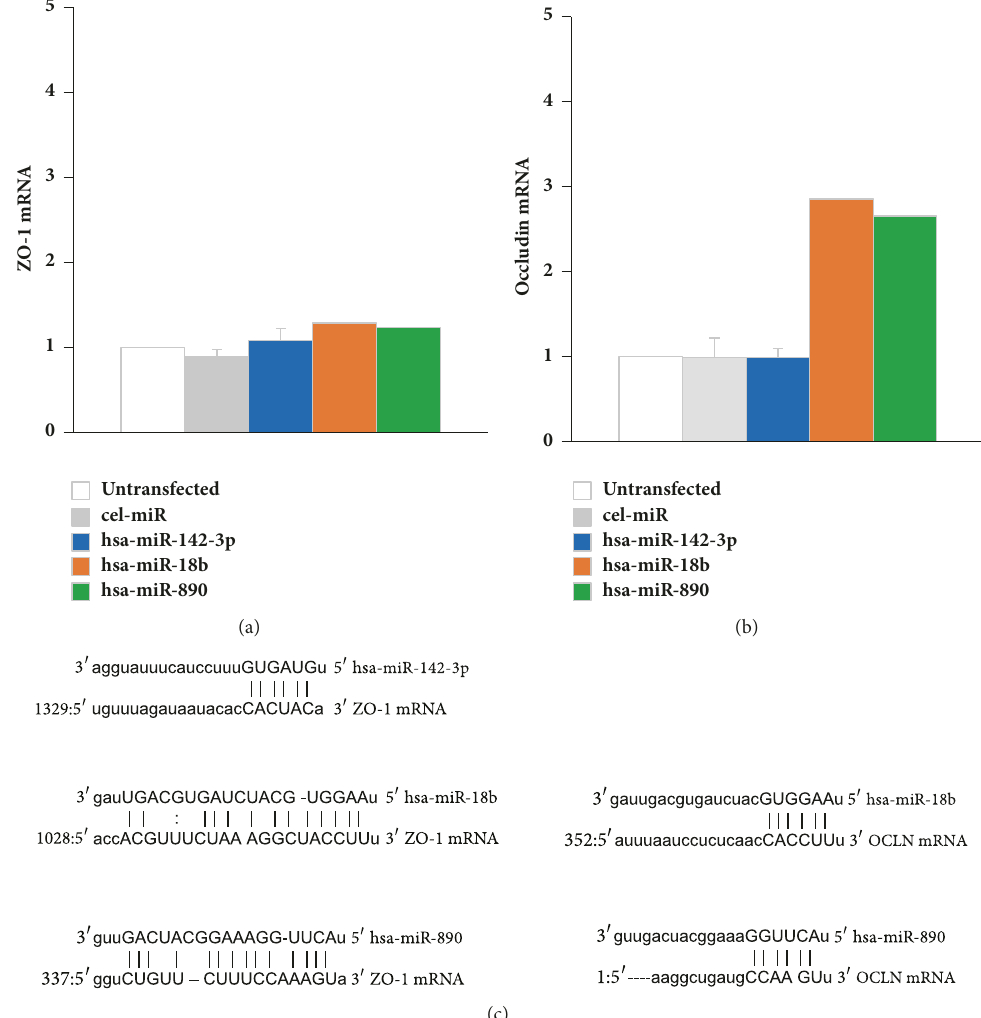
Figure 3: Transfection of MetS-FL miR mimics into CRL-1790 cells did not directly affect cellular ZO-1 (a) or Occludin (b) mRNA levels, although mRNA target sequence alignments with each of MetS-FL miRs were predicted